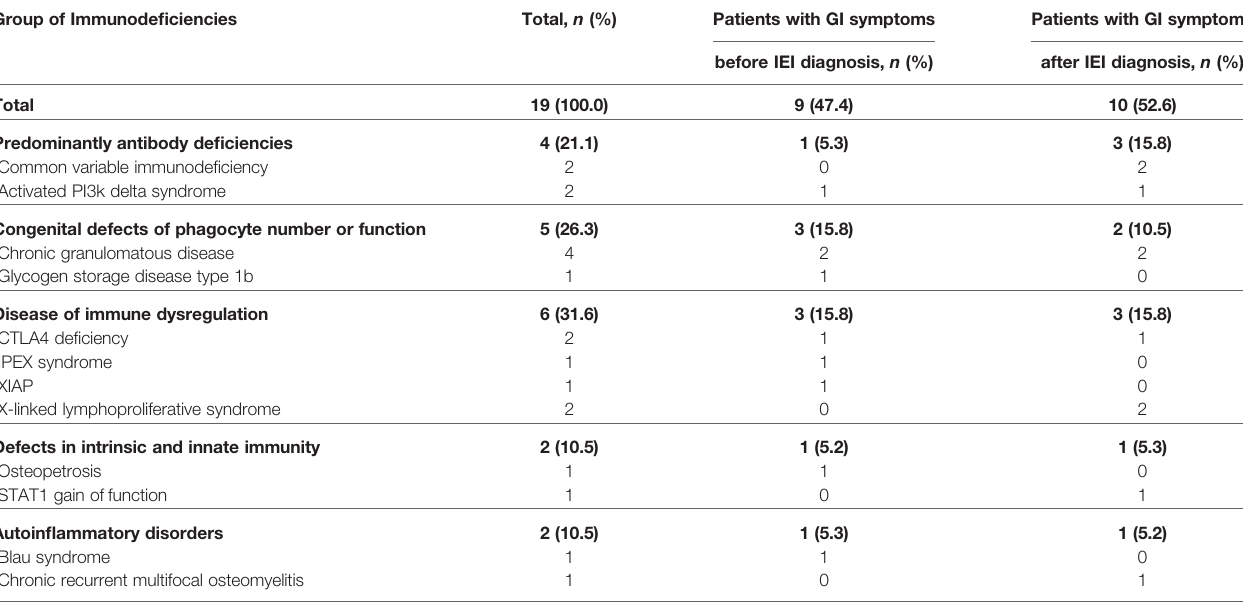
TABLE 1 | Distribution of IEI patients with severe GI symptoms enough to require